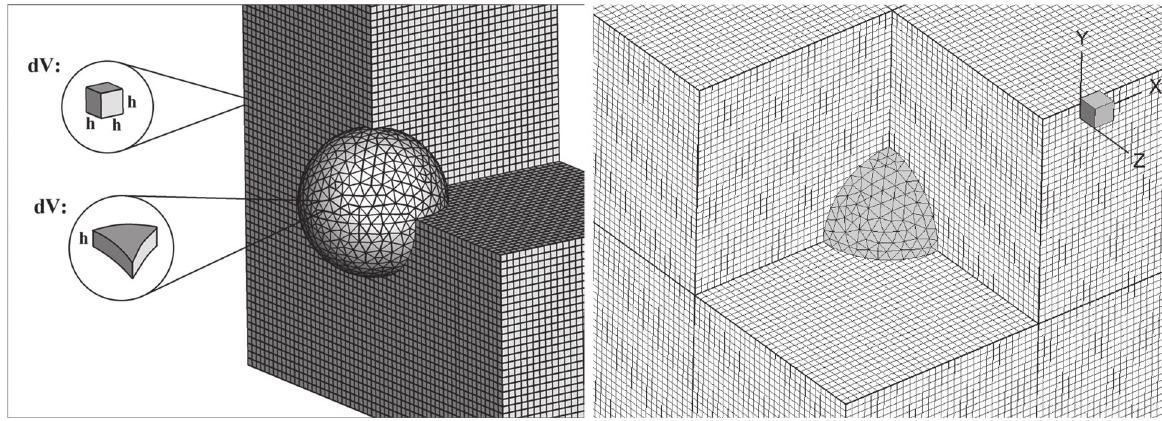
Figure 14 - Eulerian and Lagrangian mesh and control